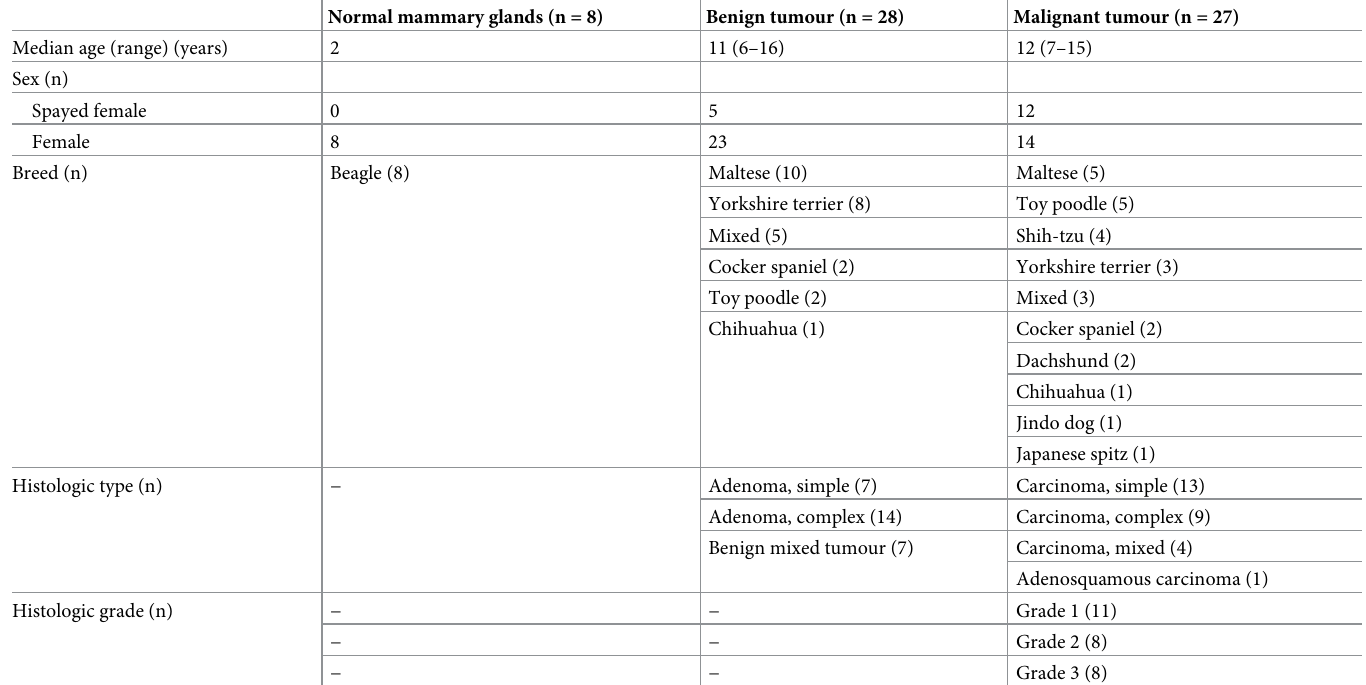
Table 1. Clinical parameters of the dogs included in this